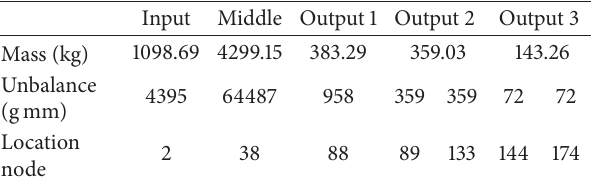
Table 2: Five shafts unbalance and location.